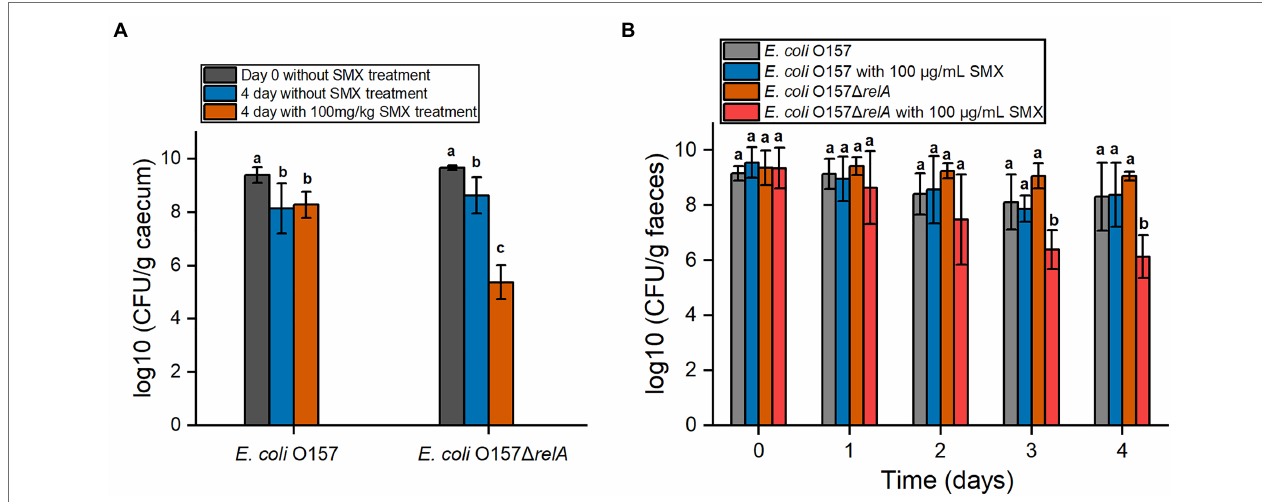
FIGURE 6 | In vivo efficacy of SMX against E. coli O157 and E. coli O157 Δ relA . (A) Viable bacterial cell counts in cecal samples. The day begins from the time of intragastrical administration. (B) Viable bacterial cell counts in fecal samples. Letters above bars indicate statistically significant differences between means, as determined by one-way analysis of variance (ANOVA) followed by Tukey’s multiple comparison tests among time points for each strain (A) or among strains at each time point (B) . Error bars represent the standard